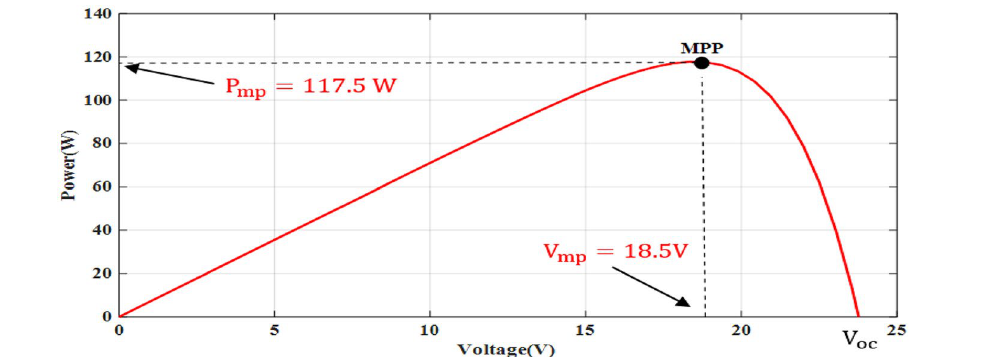
Figure 9. P – V graph of single-diode model at STC.